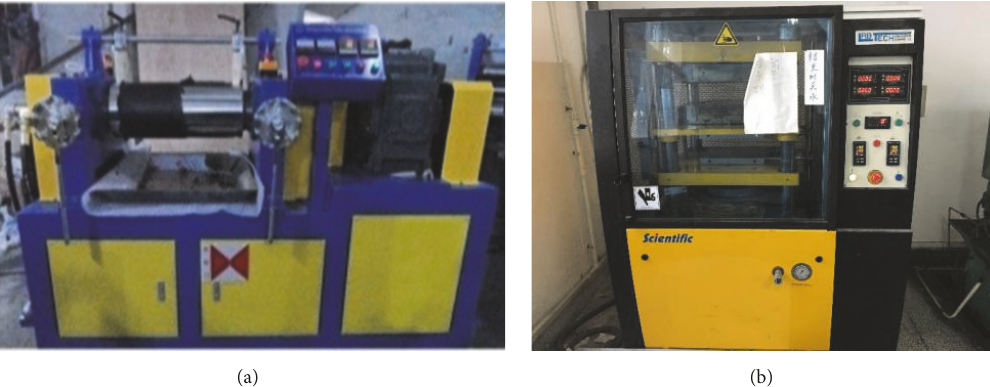
Figure 2: The material preparation devices: (a) open mixing mill, (b) vulcanizing press device.